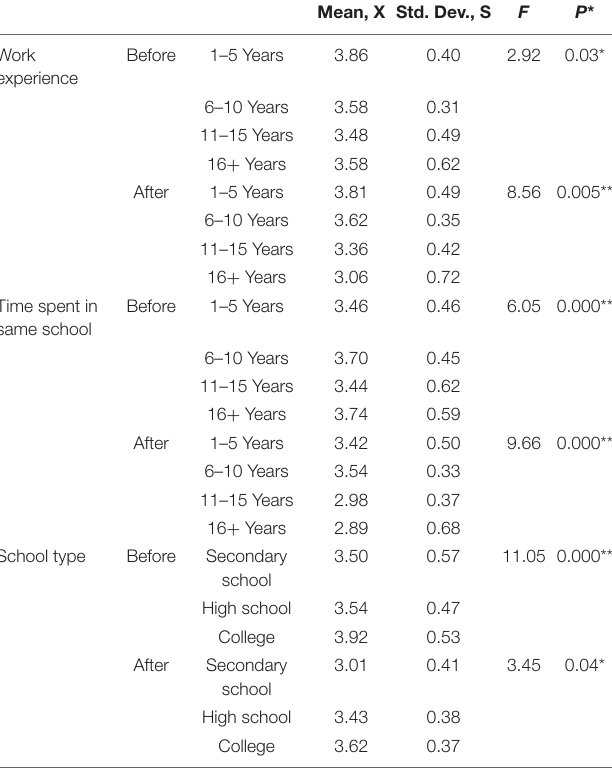
TABLE 4 | ANOVA test results. Mean, X Std. t P * Work Dev., S